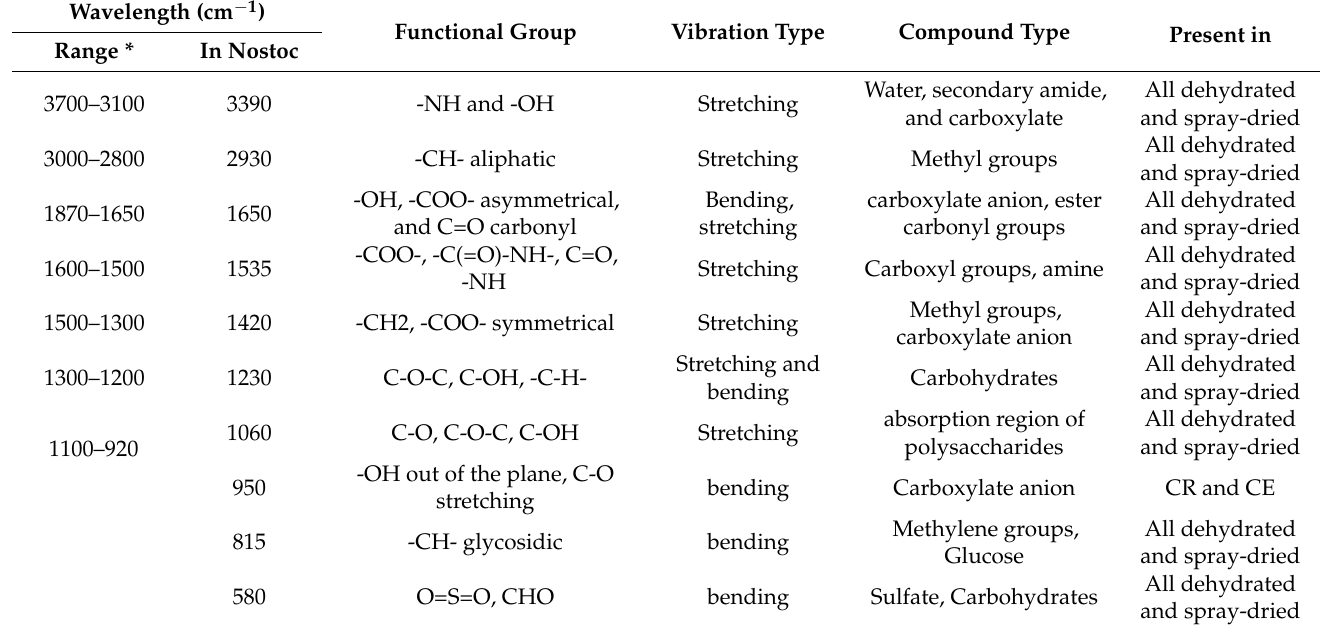
Table 6. Fourier transforms infrared (FTIR) spectra for